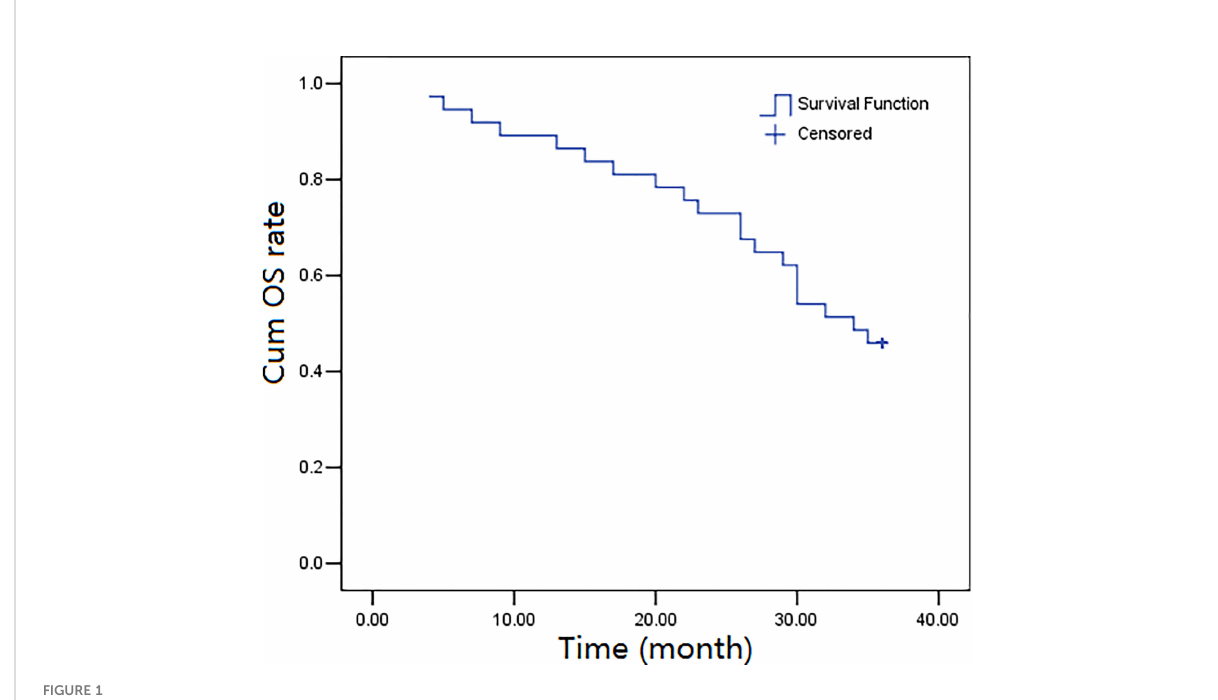
FIGURE 1 Kaplan-Meier overall survival (OS) curves for 37 cases.